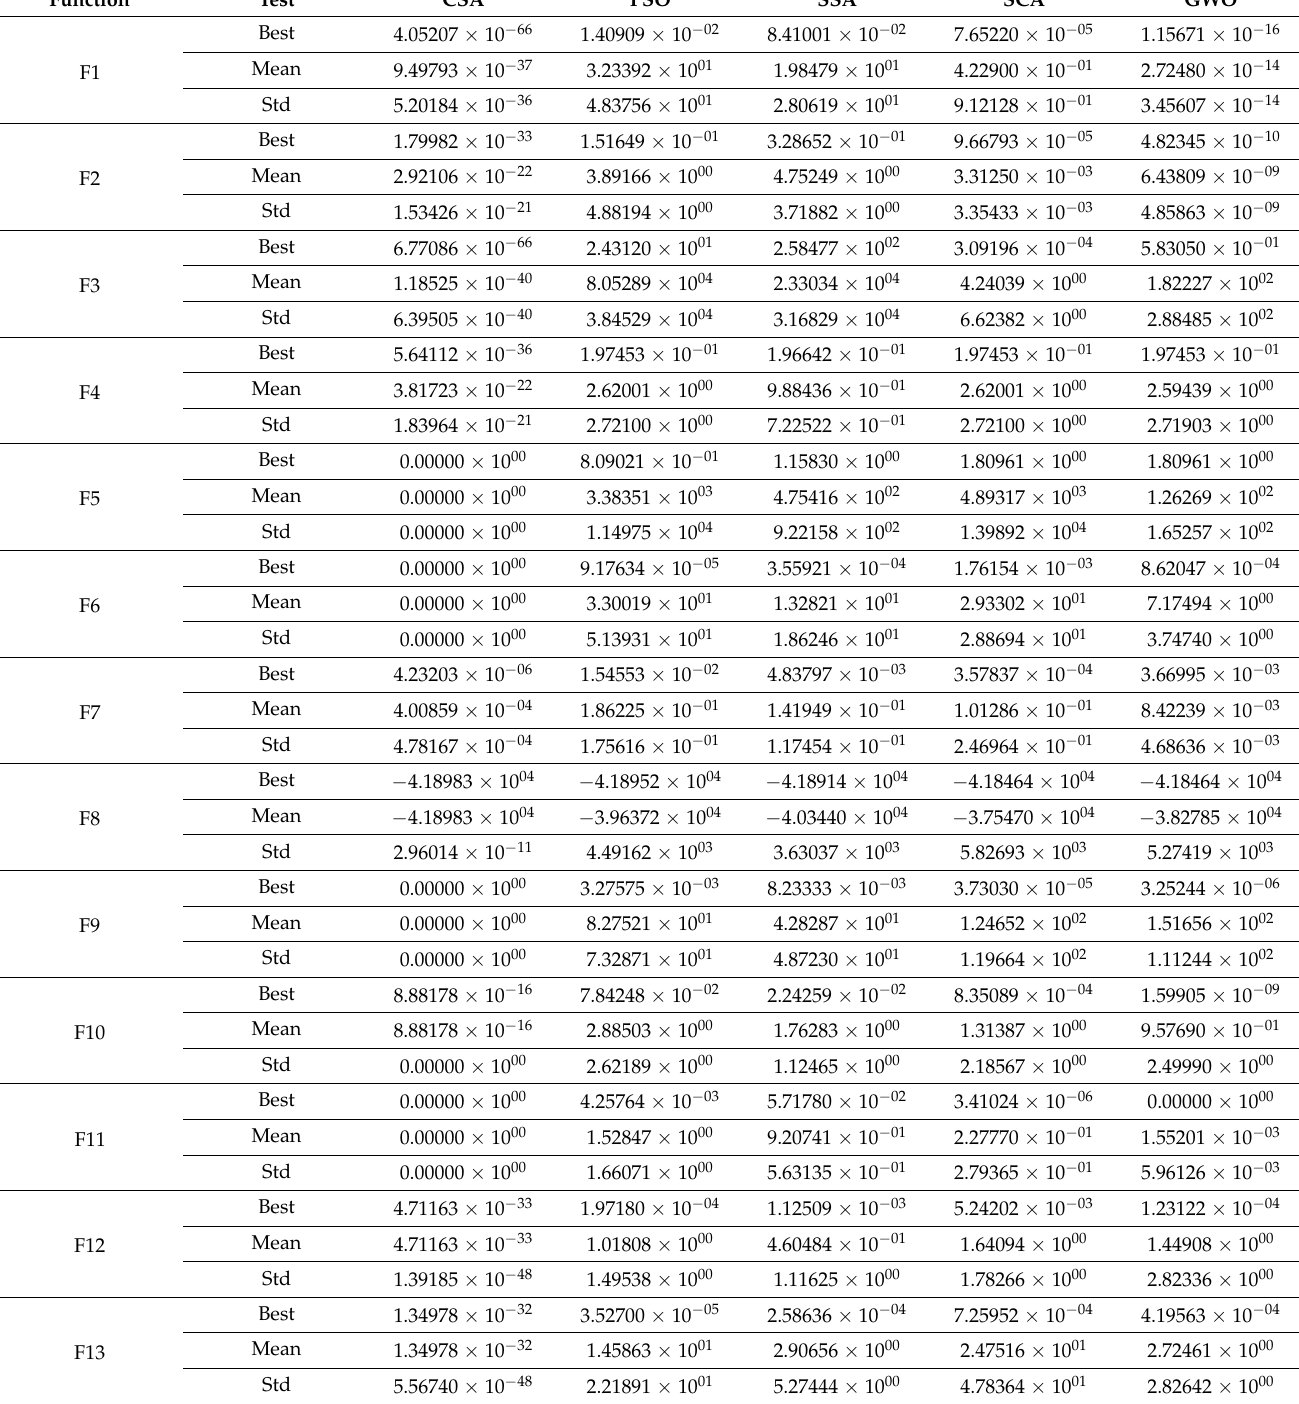
Table 8. Statistical results of the optimized standard functions with d =